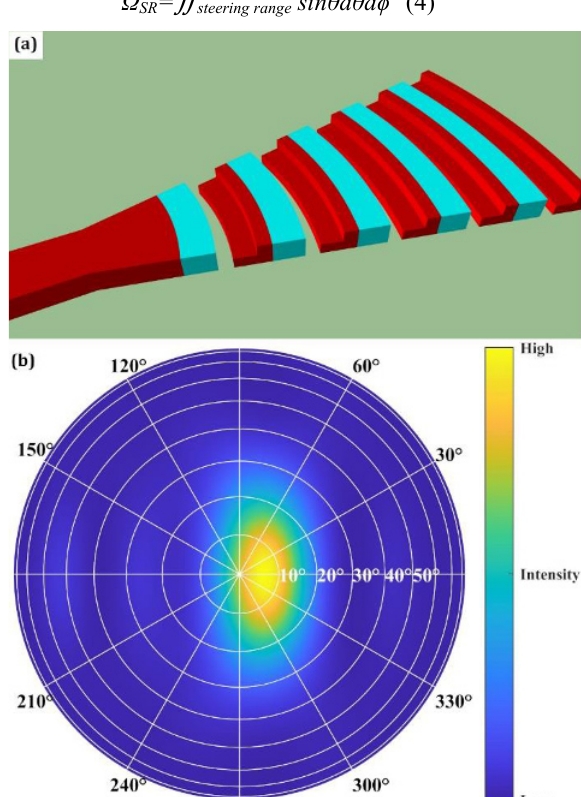
Fig. 3. (a) Schematic 3D view of nano antenna; (b) The corresponding far-field radiation pattern of the optical nanoantenna at λ = 1550 nm, calculated from the near -field emission using the near-to-far-field transformation.